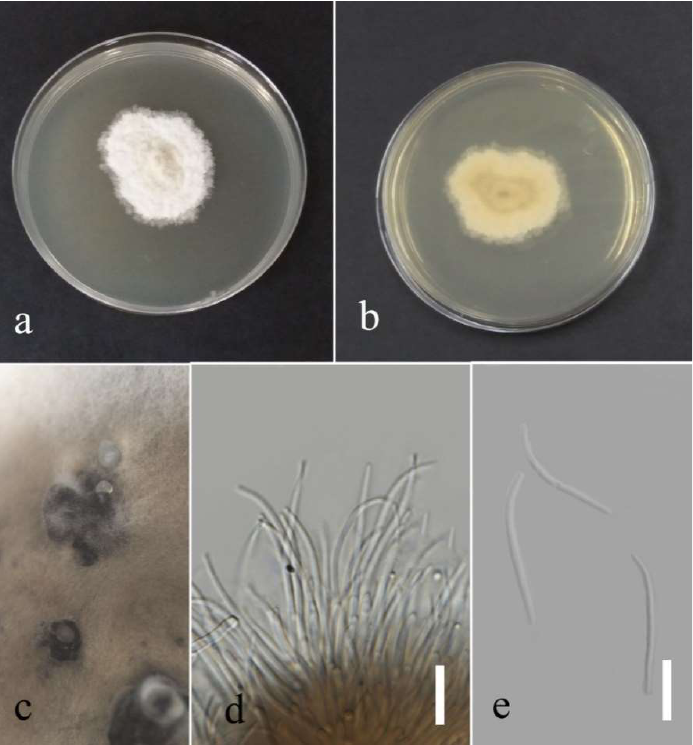
Figure 18. Morphology of Diaporthe heveae based on isolate MFLUCC 22 - 0146: ( a , b ) upper and reverse views of the colony after seven days of growth on PDA at 28 °C; ( c ) pycnidia and conidial mass; ( d ) conidiophores; ( e ) beta conidia . Scale bars ( d , e ) = 10 µm .